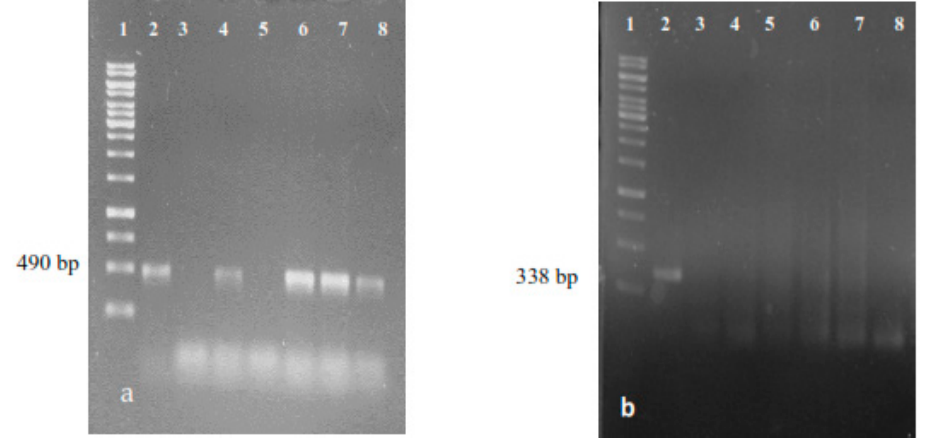
Figure 2. PCR products of transformed hairy roots derived from L . racemosa . ( a ) Amplifying a 490 bp fragment of the rolC gen of A. rhizogenes ATCC 15834. Lane 1: 1 Kb DNA marker; lane 2: Positive control, PCR product from total DNA of A. rhizogenes ATCC 15834; Lane 3: Negative control, PCR product from total DNA of non-transformed roots of L. racemosa ; lanes 4–8: PCR products from total DNA of 5 hairy root lines derived from L. racemosa , (lines 7.31, 6.14, 6.4, 3.1 and 17.6, respectively); ( b ) Amplifying a 338 bp fragment of the virD gen of A. rhizogenes ATCC 15834. Lane 1: 1 Kb DNA marker; lane 2: Positive control, PCR product from total DNA of A. rhizogenes ATCC 15834; lane 3: Negative control, PCR product from total DNA of non-transformed roots of L. racemosa ; lanes 4–8: PCR products from total DNA of 5 hairy root lines derived from L. racemosa .